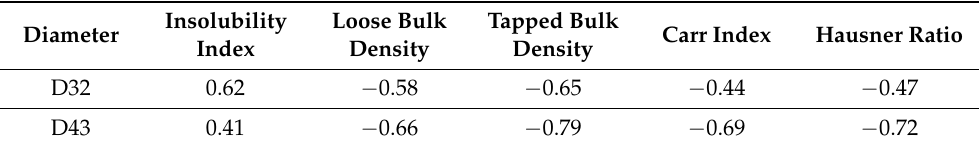
Table 4. Correlation coefficients ( r ) denoting the strength of the linear relationships between particle size and powder properties.